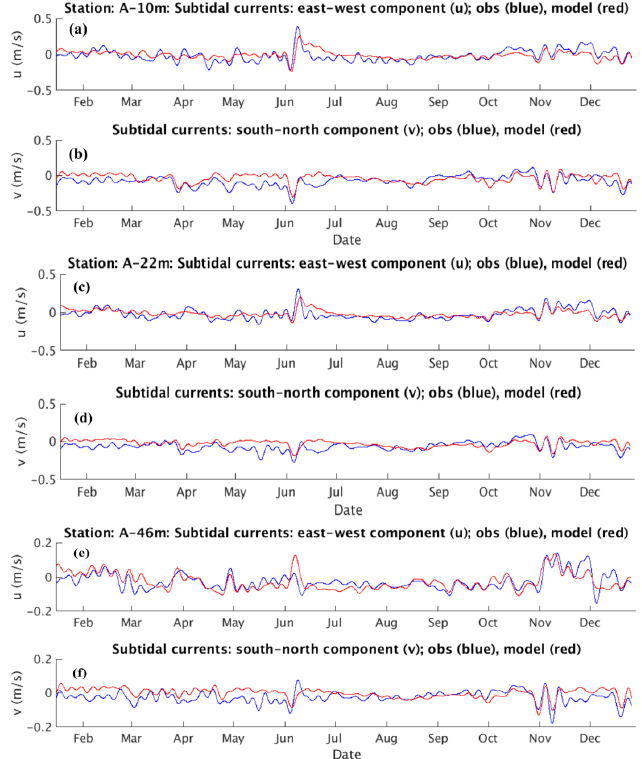
Figure 5. Comparison of the model (red lines) and the data (blue lines) time series of the current velocity (u, v) at the NeraCOOS buoy station A. The measurement depths are shown on the plots. ( a ) and ( b ) depict the u and v components at the 10 m depth; ( c ) and ( d ) depict the u and v components at the 22 m depth; and ( e ) and ( f ) depict the u and v components at the 46 m depth.